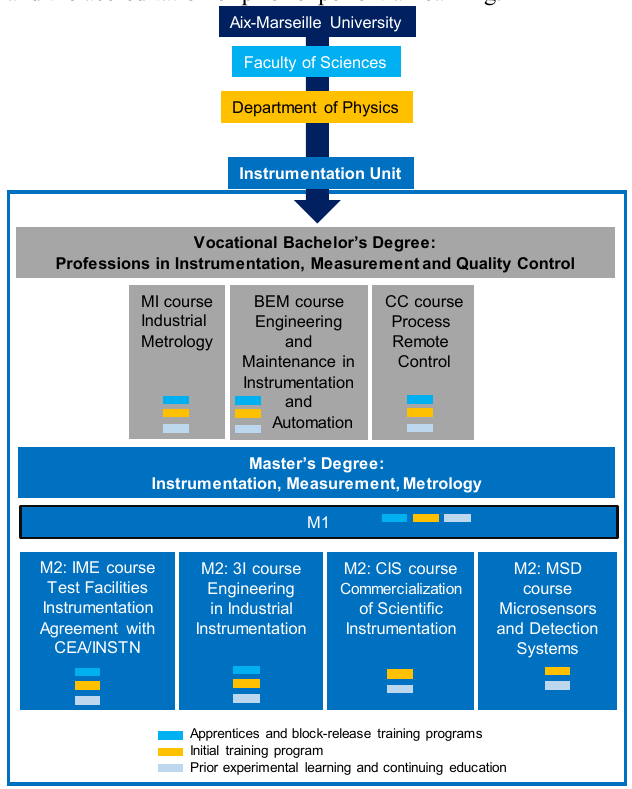
Fig. 1. Diagram of the degrees of the Instrumentation Unit (“Filière